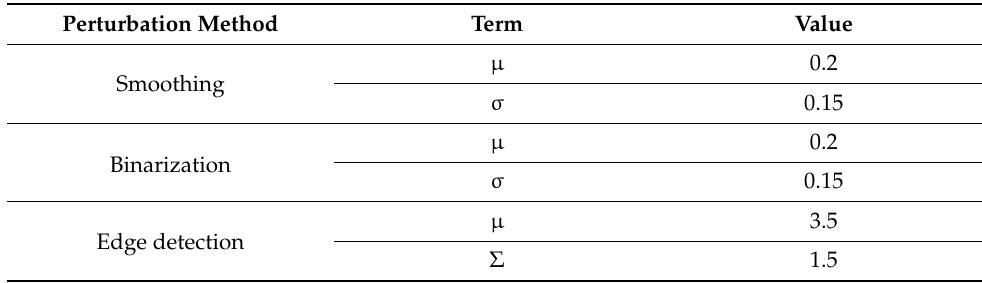
Table 2. Values of parameters used in our